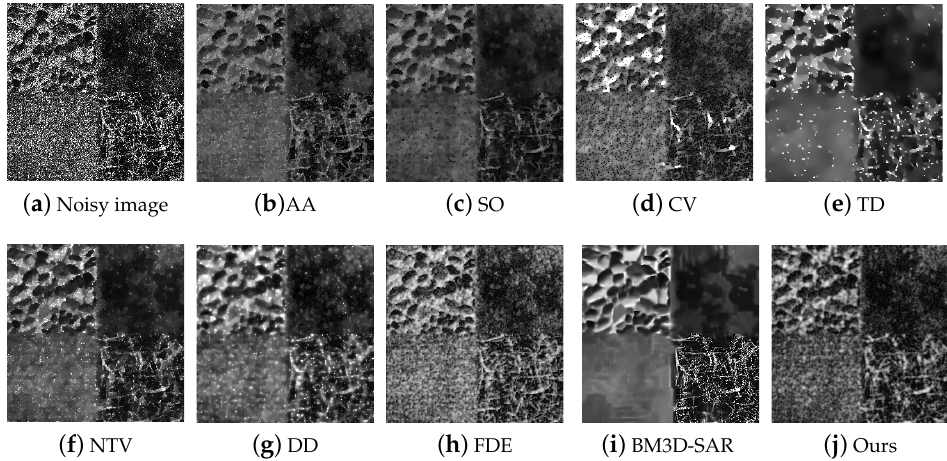
Figure 3. The despeckled results on the texture1 image: ( a ) Noisy: L = 1. ( b – j ) Despeckled results.